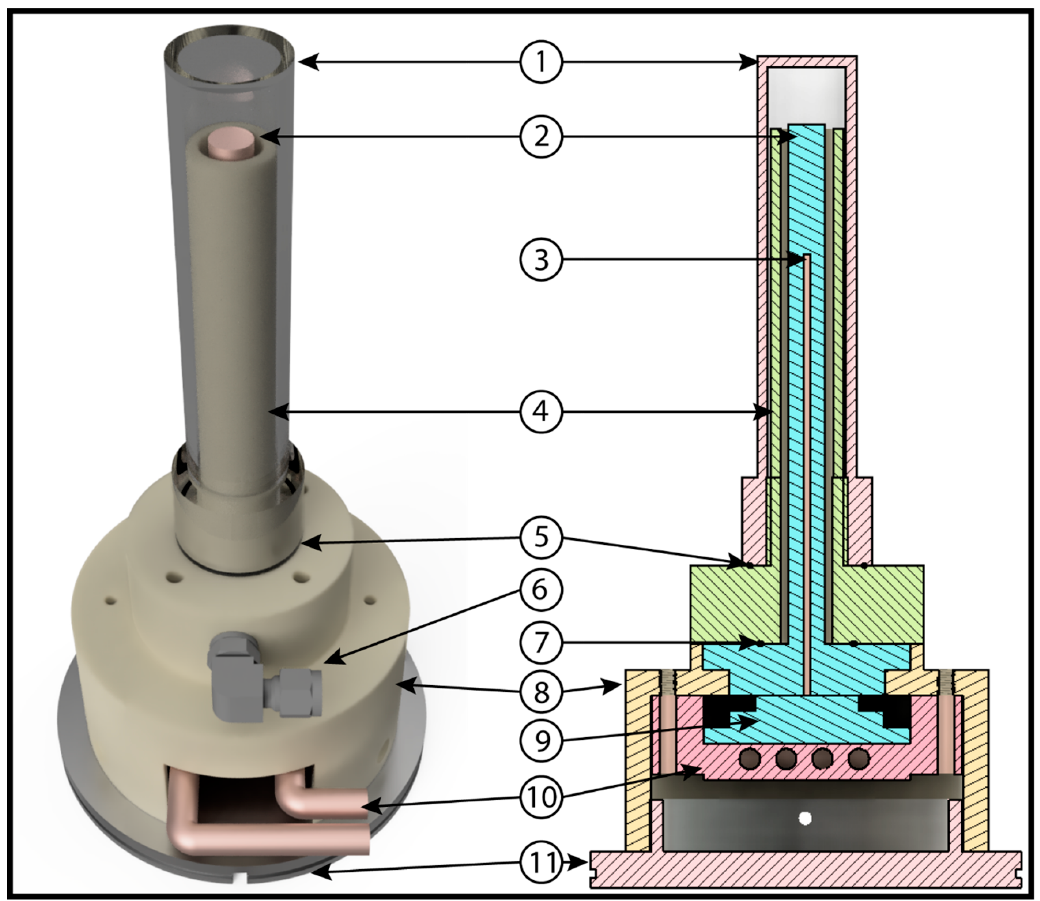
Figure 2. Isometric and sectional view of the developed freeze-drying stage for μ -CT measurements; (1) cap; (2) sample holder; (3) PT1000 bore hole; (4) vacuum chamber with thread to mount the cap; ( 1 ) cap; ( 2 ) sample holder; ( 3 ) PT1000 bore hole; ( 4 ) vacuum chamber with thread to mount the cap; (5) seal; (6) Swagelok connecter; (7) seal; (8) electrical housing; and (9) thermoelectric cooler. ( 5 ) seal; ( 6 ) Swagelok connecter; ( 7 ) seal; ( 8 ) electrical housing; and ( 9 ) thermoelectric cooler; ( 10 ) heat sink; ( 11 ) support